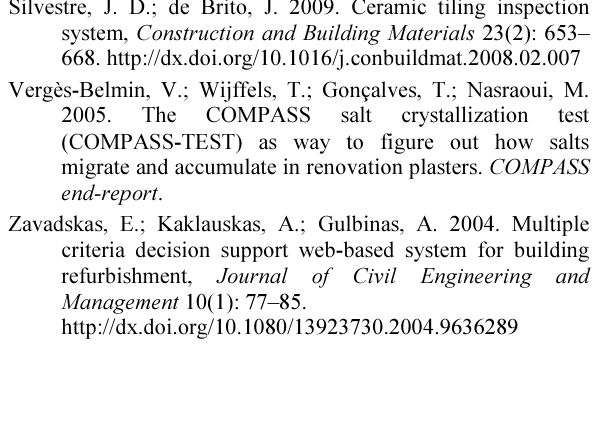
COMPASS crystallization test (COMPASS-TEST) as way to figure out how salts migrate and accumulate in renovation plasters.